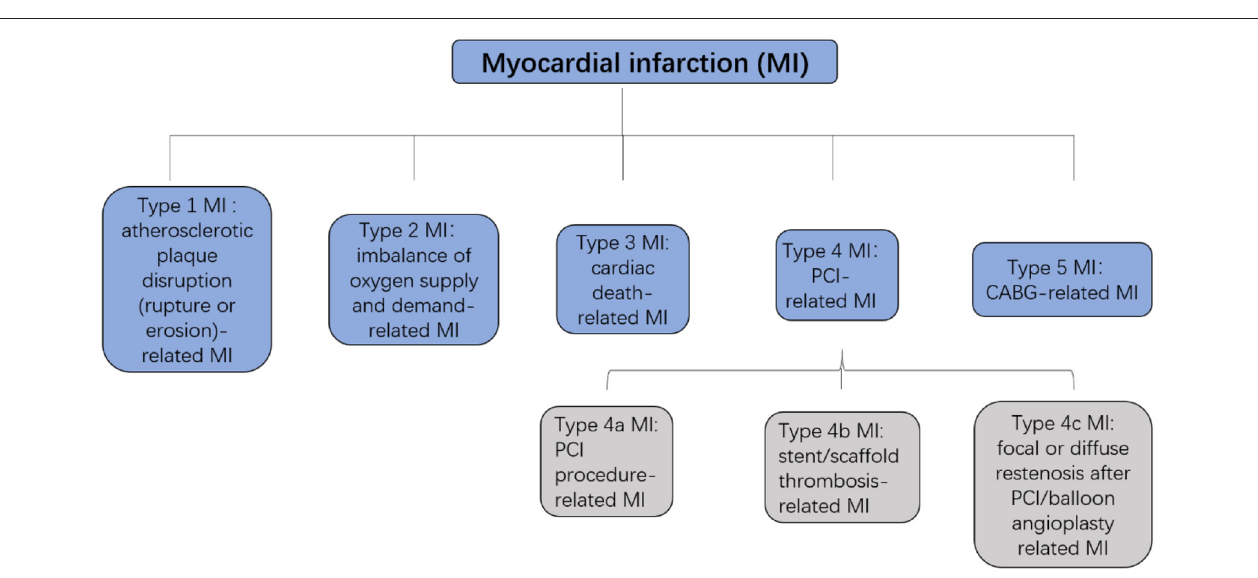
FIGURE 2 | Five types of MI. MI, myocardial infarction; PCI, percutaneous coronary intervention; CABG, coronary artery bypass